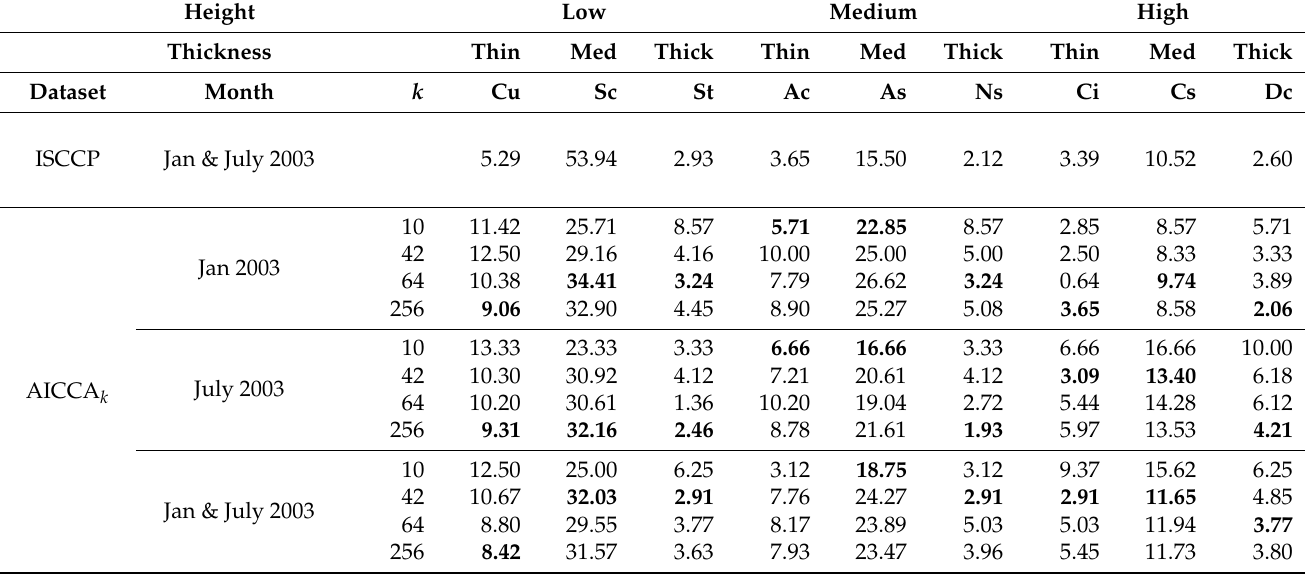
Table 5. ISCCP: Relative frequencies of occurrence based on mean COT and CTP values for OC-Patches from January and July, 2003. AICCA: Relative frequencies of occurrence of RICC clusters over each of the nine ISCCP cloud classes [3], as determined by counting the number of clusters that overlap (as determined by the mean, plus or minus one standard deviation, of COT and CTP values for patches within each cluster) with each class, divided by the total number of cluster-class overlaps. We allow double counts if a cluster overlaps more than one ISCCP class. Results are given for k =10, 42, 64, and 256 clusters, and for just January patches, just July patches, and both January and July patches. The AICCA values that are closest to the frequencies from MODIS column are in boldface. Recall that MODIS values are based on frequencies of patches over COT-CTP space, while the AICCA values are based on frequencies of clusters over COT-CTP space. Note that frequencies in each line add to 100, modulo rounding. We observe that the AICCA cluster frequencies are roughly proportional to the ISCCP category frequencies, although they consistently underestimate the Sc class (by 20%) and overestimate Cu and As classes.